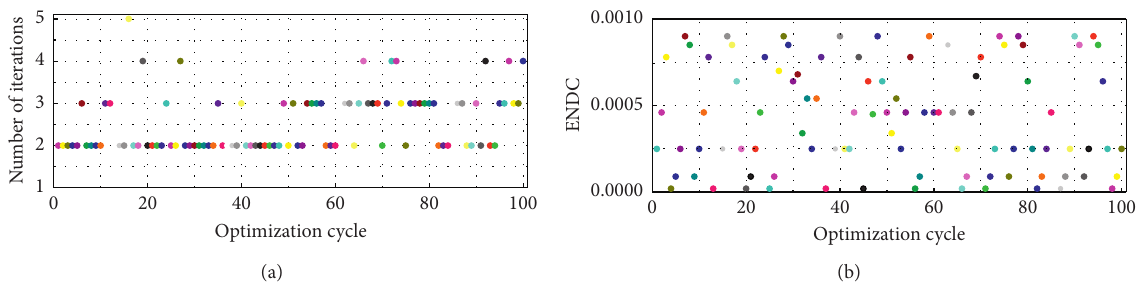
Figure 10: (a) The iterative convergence of the optimization solution. (b) The number of iterations of the optimization solution.